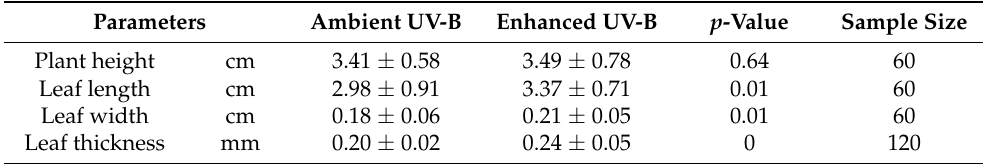
Table 1. Effects of enhanced UV-B on plant growth parameters of K. humilis .